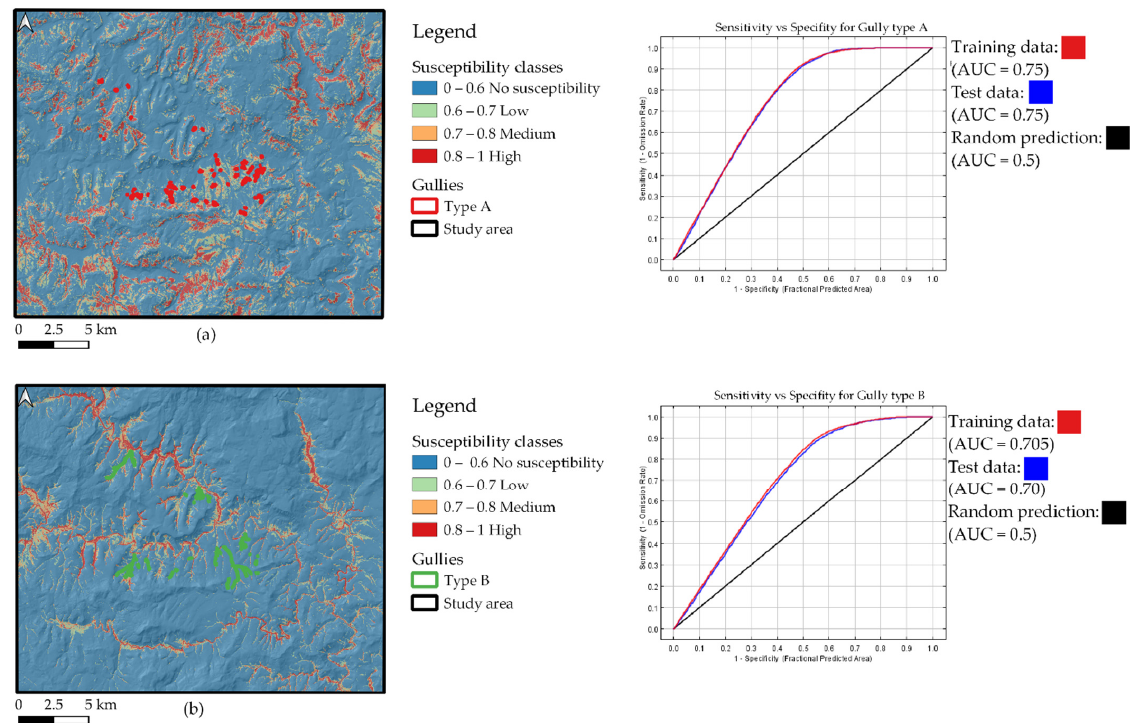
Figure 7. MaxEnt model susceptibilities for the two gully erosion types: ( a ) susceptibility maps, ROC curves and AUC values for gully type A; ( b ) susceptibility maps, ROC curves and AUC values for gully type B.